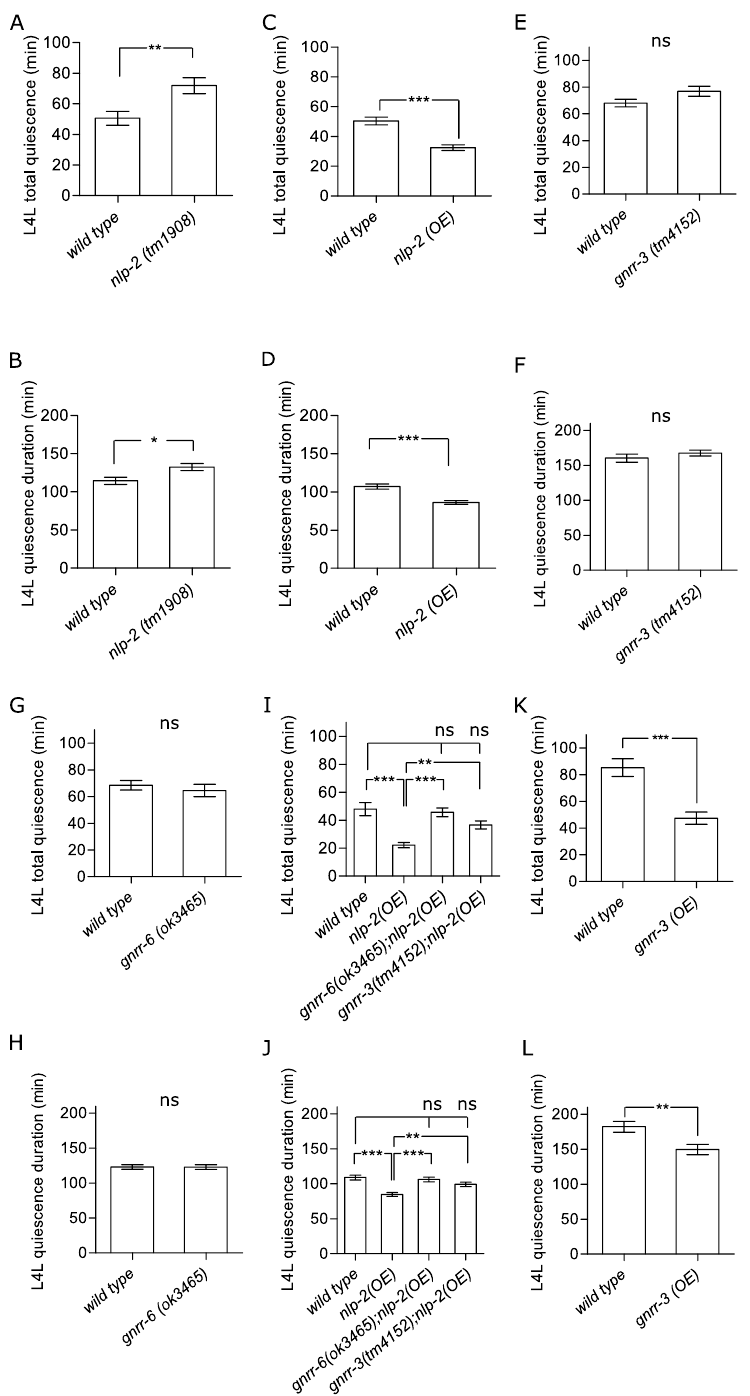
Figure 5. GNRR-3 and GNRR-6 are required for the wake-promoting effects of nlp-2 overexpression. Average total quiescence during L4 lethargus (L4L) and average quiescence duration of L4L for ( A , B ) nlp-2 mutants (N ≥ 20 animals) and ( C , D ) animals overexpressing nlp-2 from an nlp-2p::nlp-2 transgene (N > 27 animals). ( E , F ) Mutants for gnrr-3 (N > 15 animals) and ( G , H ) g nrr-6 (N > 21 animals) are not defective in lethargus quiescence. ( I , J ) Disrupting gnrr-3 or gnrr-6 abolishes locomotory quiescence in animals overexpressing nlp- 2 (N ≥ 31 animals). ( K , L ) Animals overexpressing gnrr-3 show increased movement quiescence during L4L (N = 18 animals). Student’s two-tailed t-tests or One-way ANOVA and Tukey test; *** P < 0.001; ** P < 0.01; * P < 0.05; ns, not significant ( P > 0.05); error bars represent